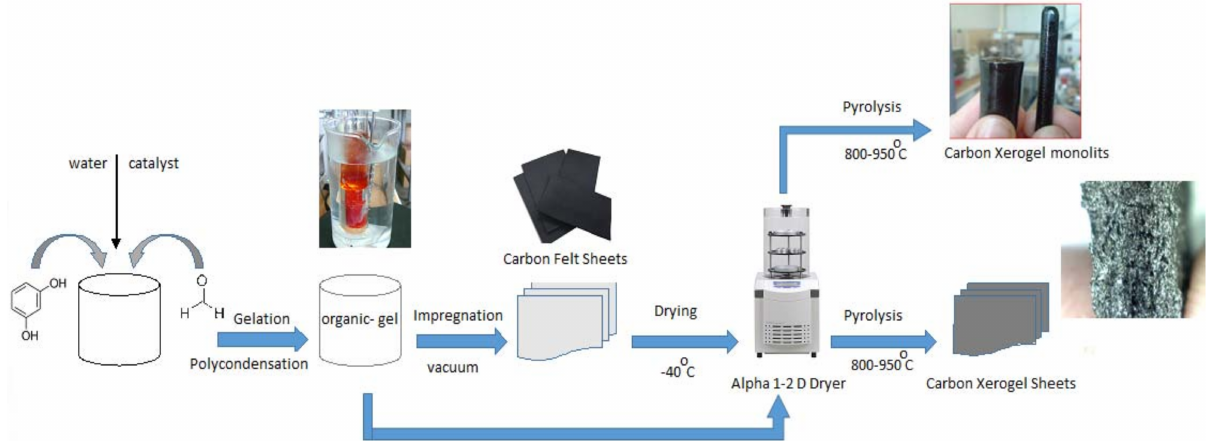
Figure 1. Schematic representation of the overall CX sheets electrodes synthesis